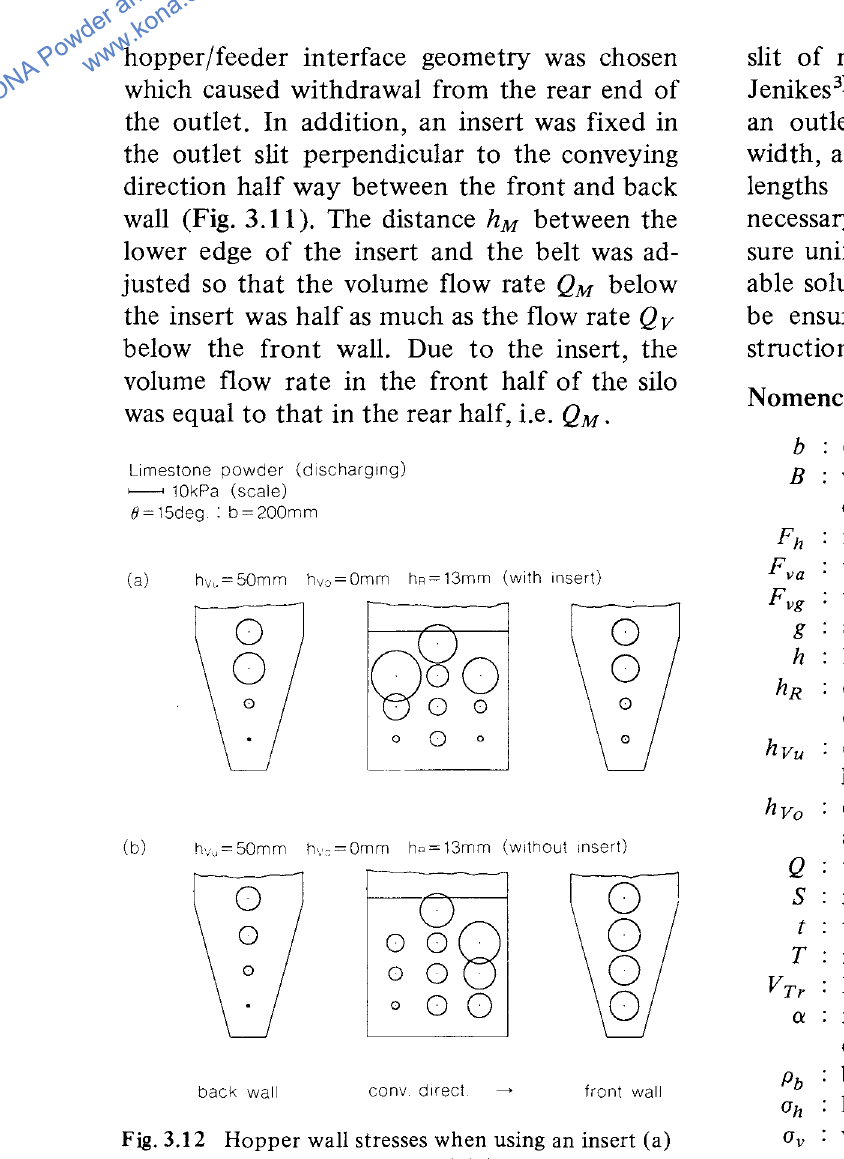
f filling e : discharging be : beginning